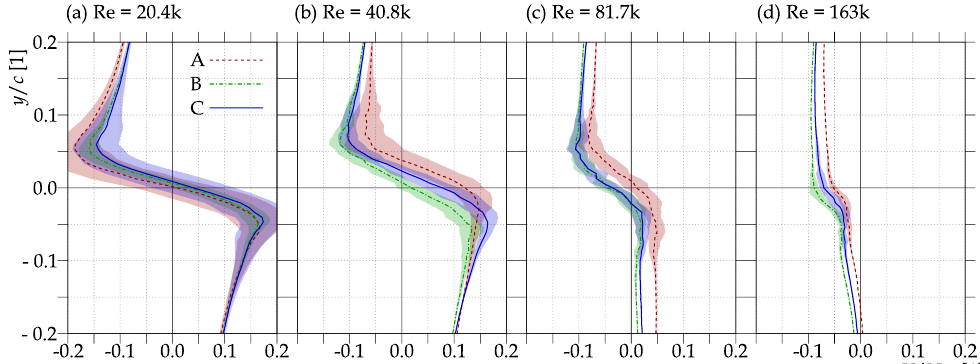
Figure 7. The cross-stream profile of average cross-stream velocity (cid:104) v (cid:105) at stream-wise distance 10mm = 1/8 c past the trailing edge. Angle of attack α = 0 ◦ in all